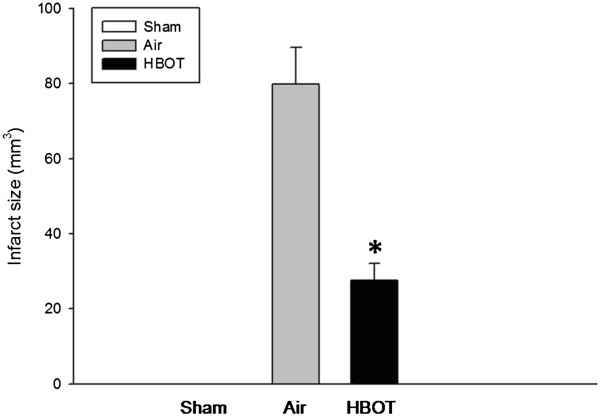
Changes of infarct volume at 28 days after HBOT. The infarct volume was calculated in mm3 of infarcted tissue per ipsilateral hemisphere. *P < 0.05 vs air group. The animal number was 20, 20 and 22, respectively in the sham, air and HBOT group.